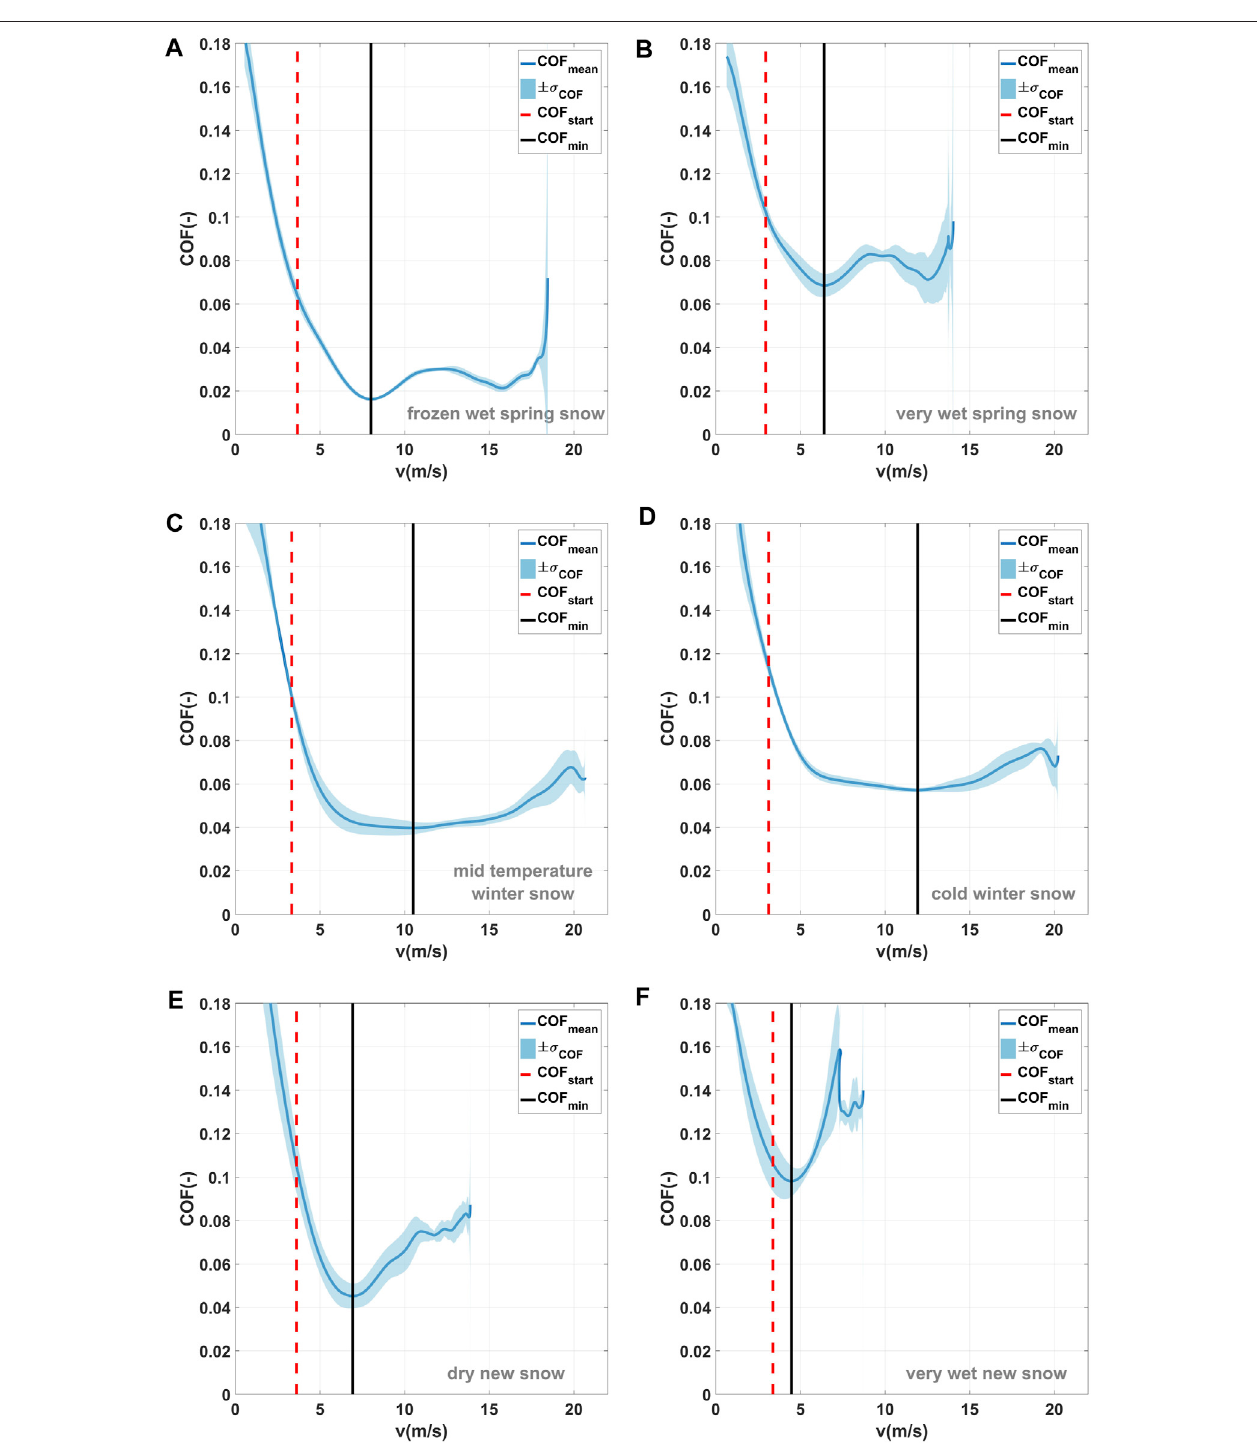
FIGURE 5 | Mean COF – speed curves with error bands ( ± σ ) and vertical lines to mark COF start and COF min for six snow categories: (A) skis on frozen spring snow ( n (cid:1) 4). (B) Skis on very wet spring snow ( n (cid:1) 4). (C) Skis on winter snow ( n (cid:1) 3). (D) Skis on cold winter snow ( n (cid:1) 5). (E) Snowboard on dry new snow ( n (cid:1) 5). (F) Snowboard on very wet new snow ( n (cid:1)